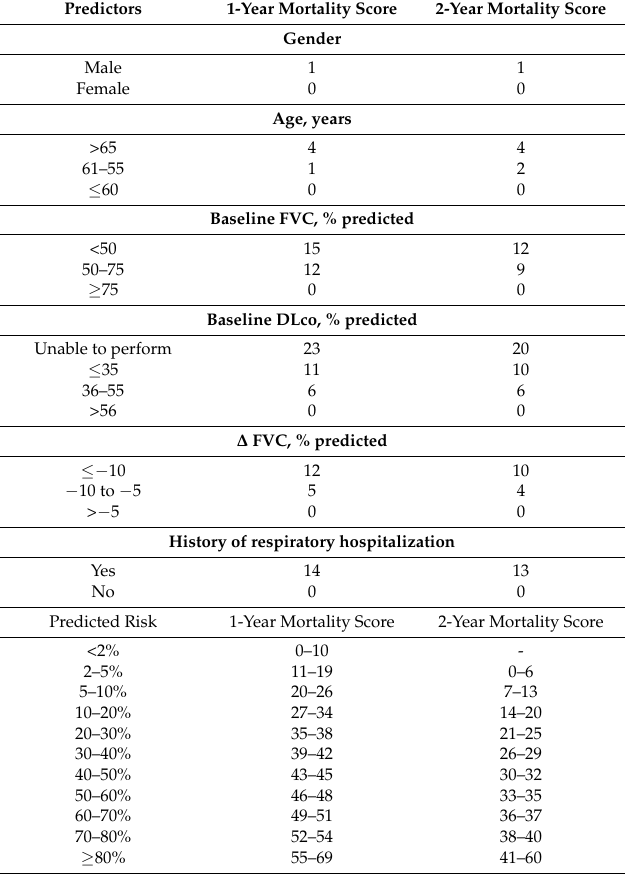
Table 5. Longitudinal GAP